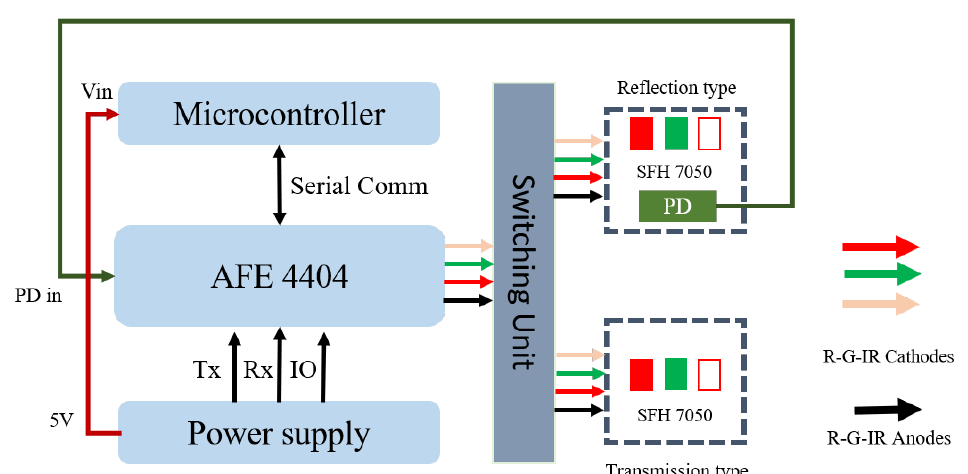
Figure 6. Block diagram of proposed hardware for data acquisition.